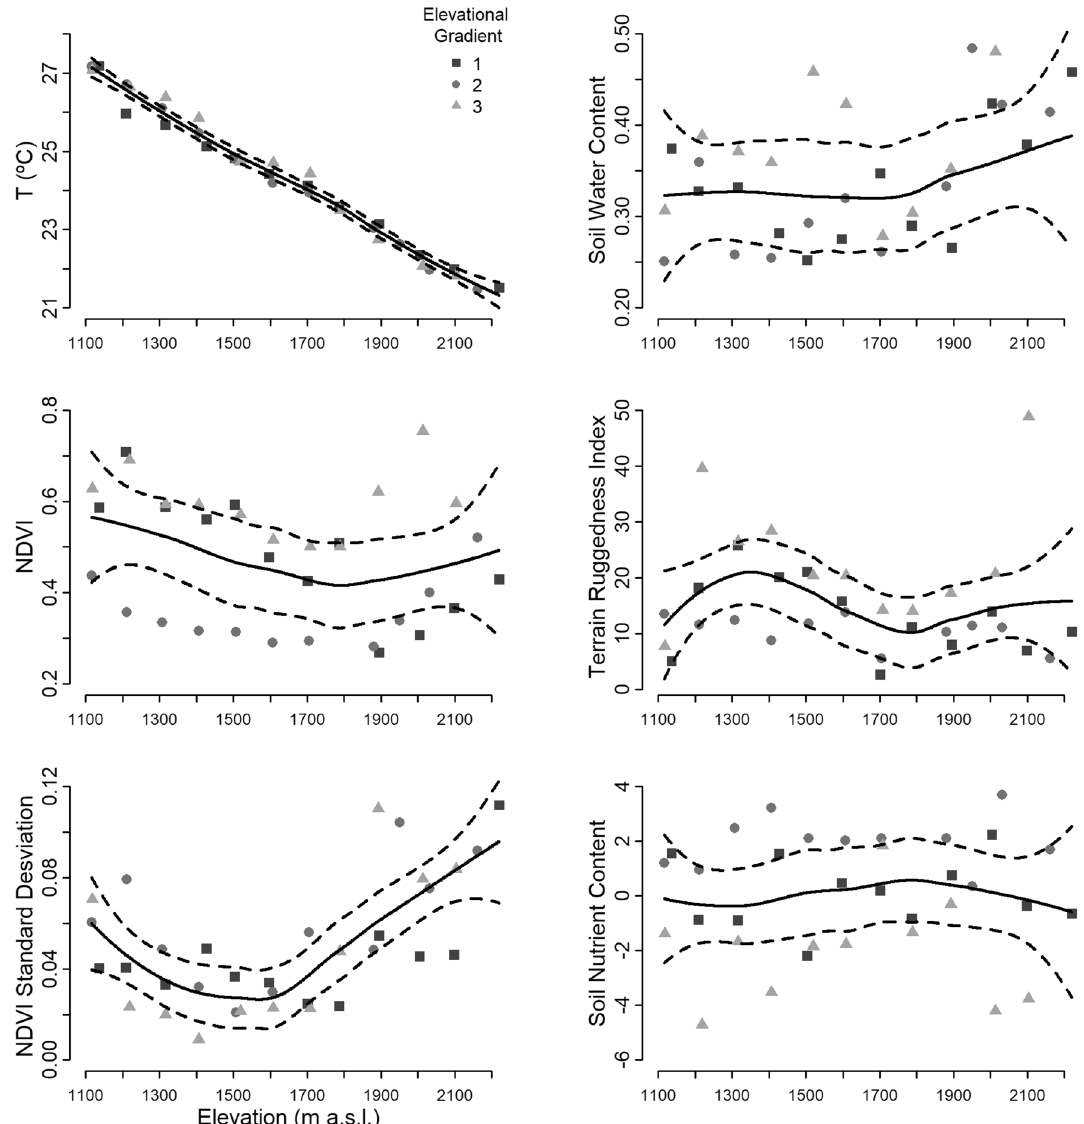
Figure 1. Elevational patterns of each environmental variable for the three gradients. The line is a local regression model for the three mountains together with a 95% confidence interval. Figure generated using R software 23